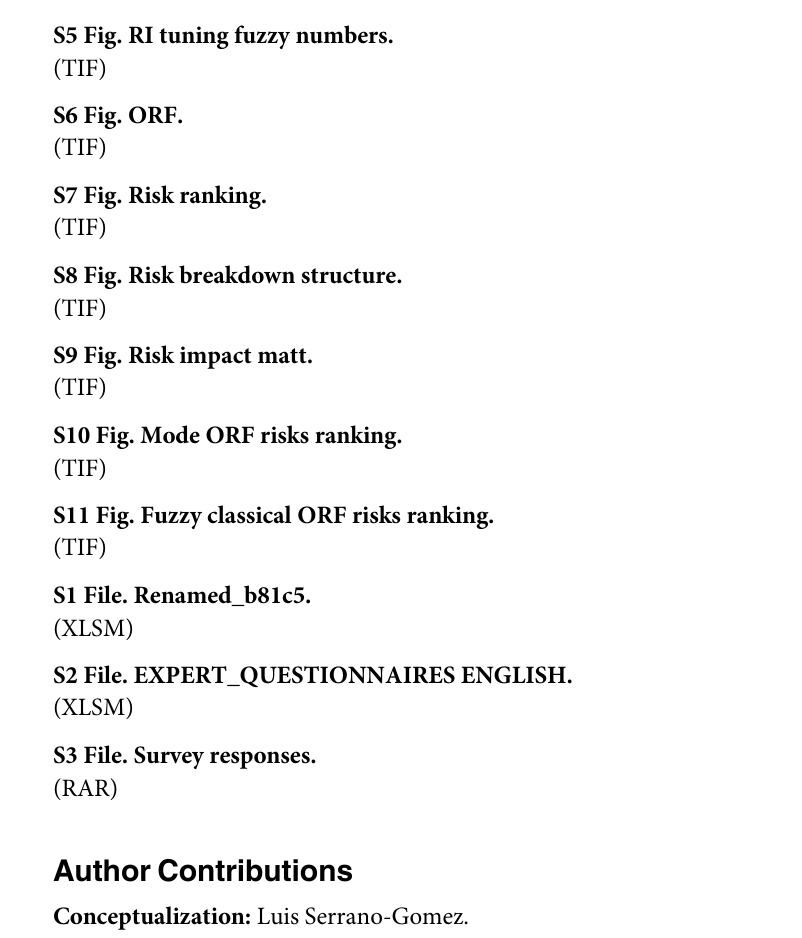
S5 Fig. RI tuning fuzzy numbers.